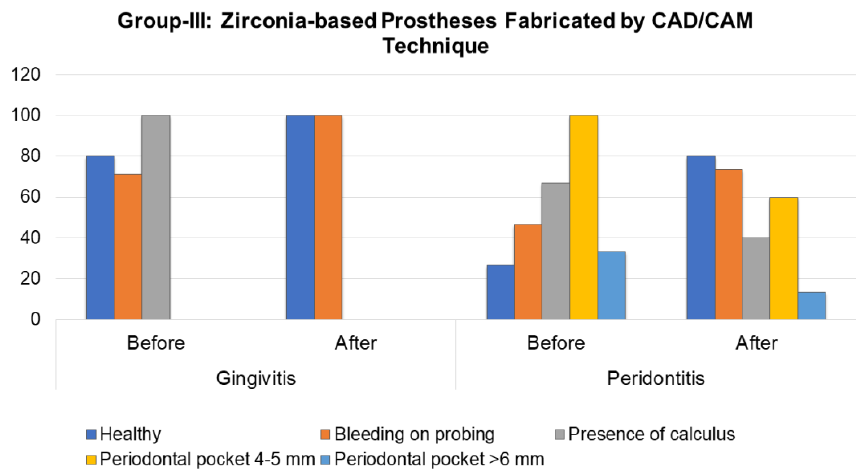
Figure 3. Periodontal status evaluation before and after the prosthetic rehabilitation in observation Group-III patients.